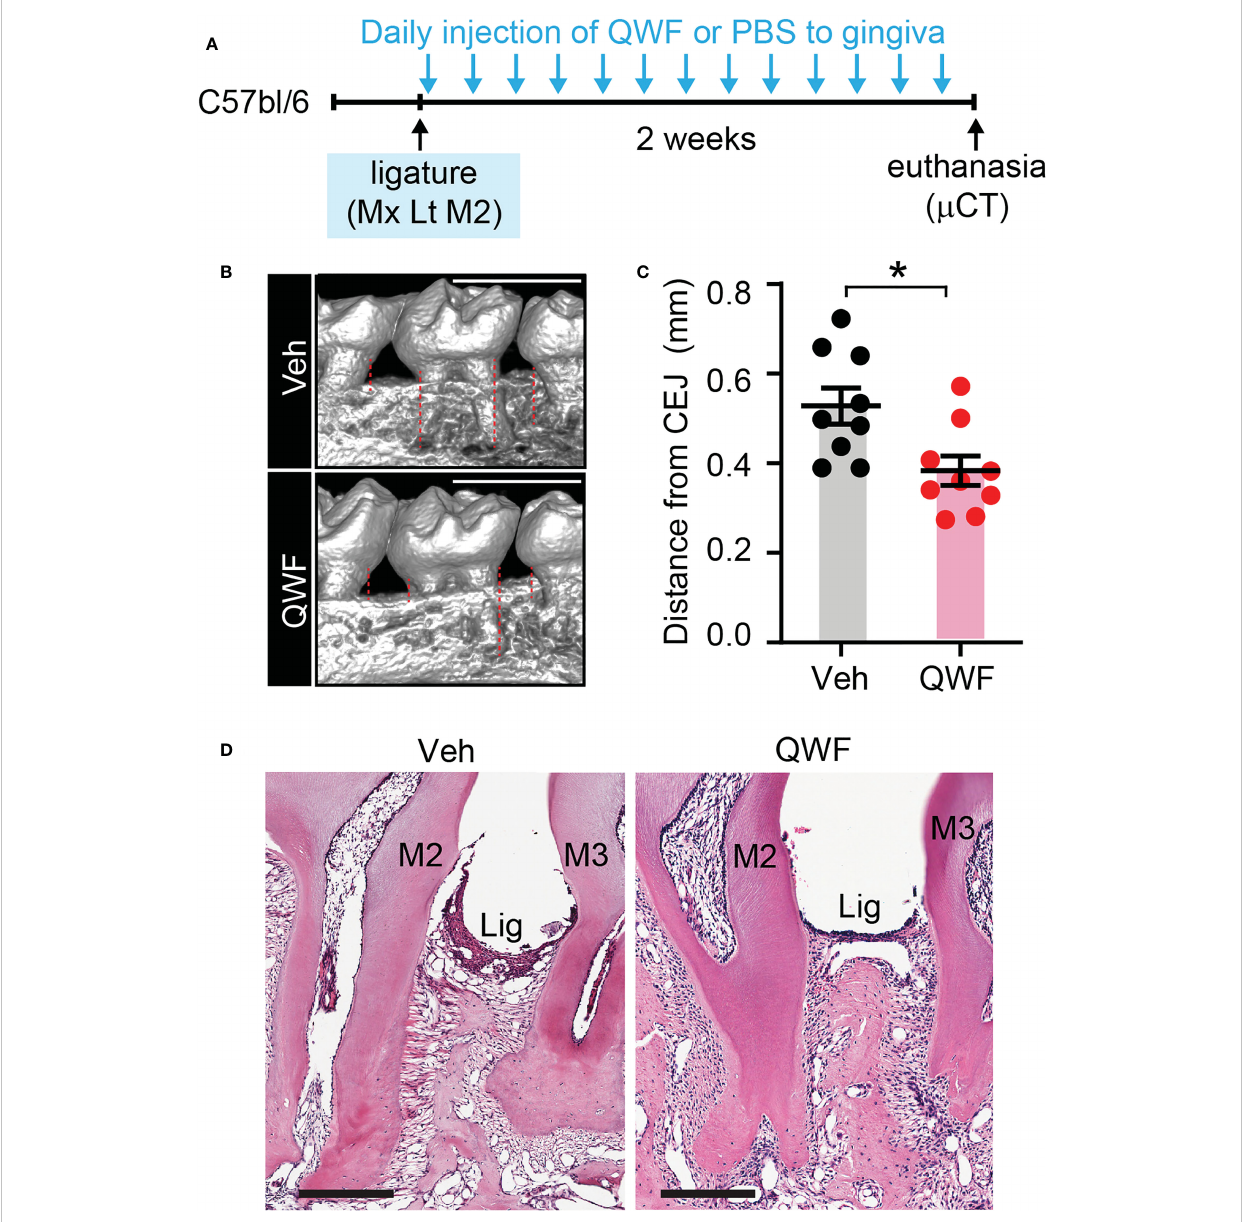
FIGURE 10 Substance P receptor antagonist reduces ligature-induced periodontitis. (A) Time course of the experiment. Under iso fl urane anesthesia, QWF (2 µg/ site) or vehicle (PBS) was injected twice a day into two sites in the gingiva around the maxillary second molar; one site between the fi rst and second molars, and the other site between the second and third molars) for 14 days after placing the ligature. (B) µCT examination of a periodontium with vehicle or QWF injection. Scale bar, 1 mm. Dotted lines represent the measurements. (C) Quanti fi cation of bone loss. *p<0.05 in Student ’ s t-test. (D) Representative images of H&E stained sagital sections. N=8 per